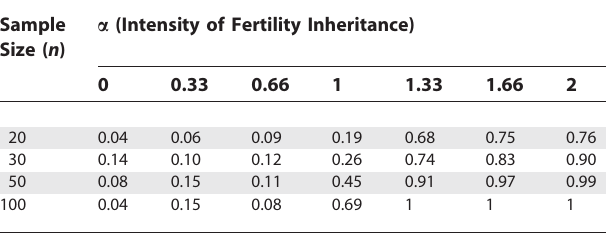
Table 1. The Power of the Mean I 9 Test to Detect Tree Imbalance for Several Values of the Fertility Inheritance Parameter a Sample Size ( n )